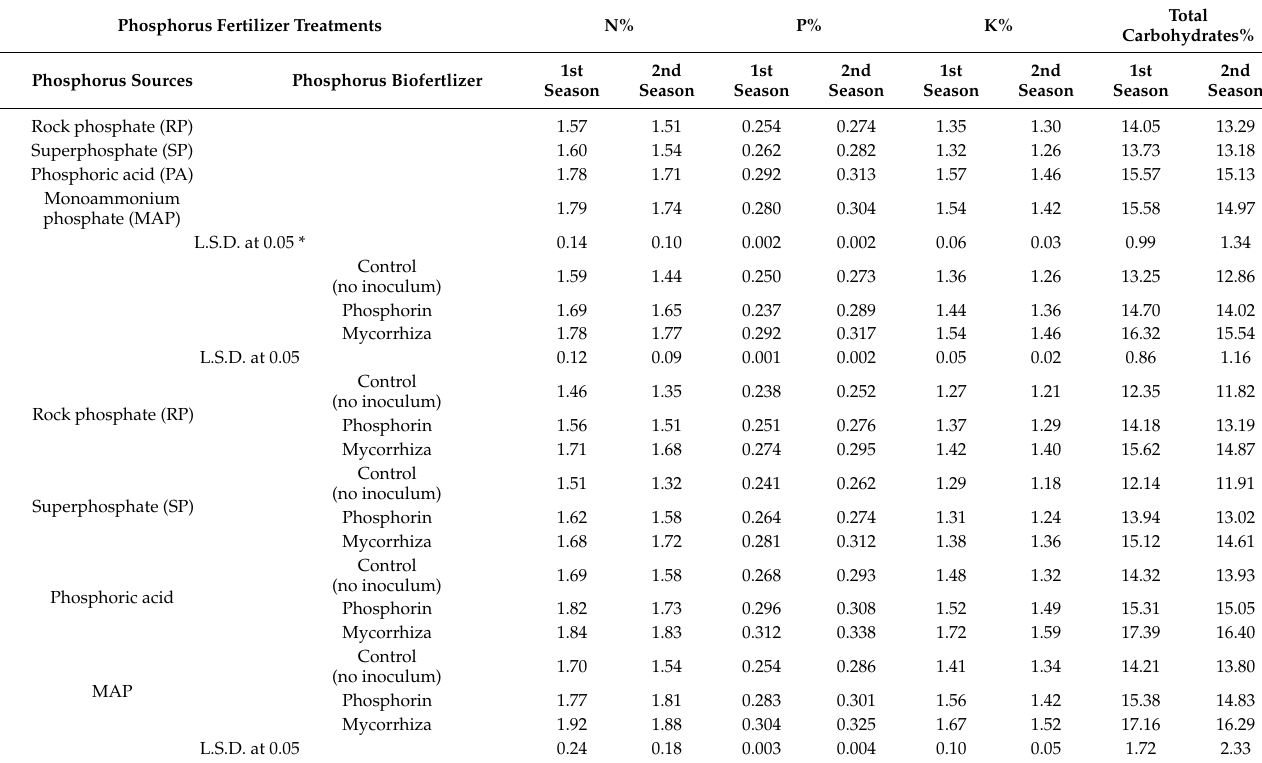
Table 7. The effect of phosphorus sources and bio-fertilizers application on the chemical composition of foliage of broccoli plants during the 2018 (1st) and 2019 (2nd)